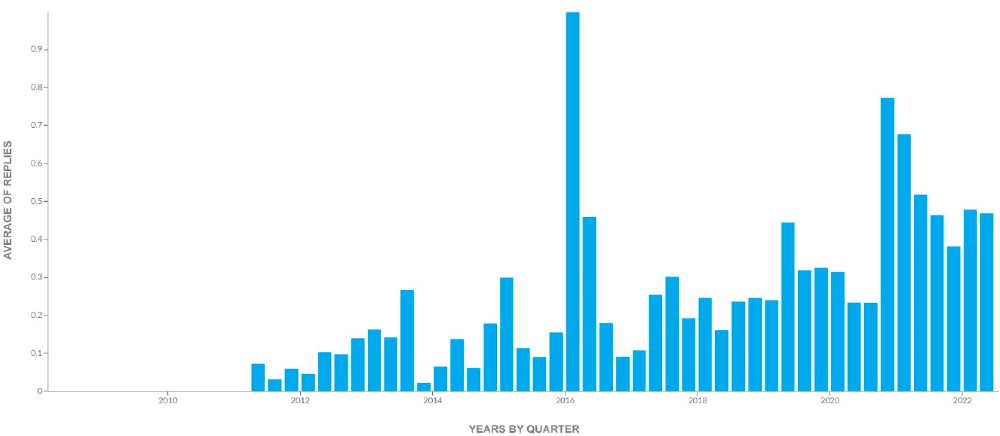
Figure 2. Average numbers of replies to Tweets mentioning cultured meat from 1 January 2005 to 30 June 2022. The figure shows the reply peaks in cultured-meat-based communications on the social network Twitter.